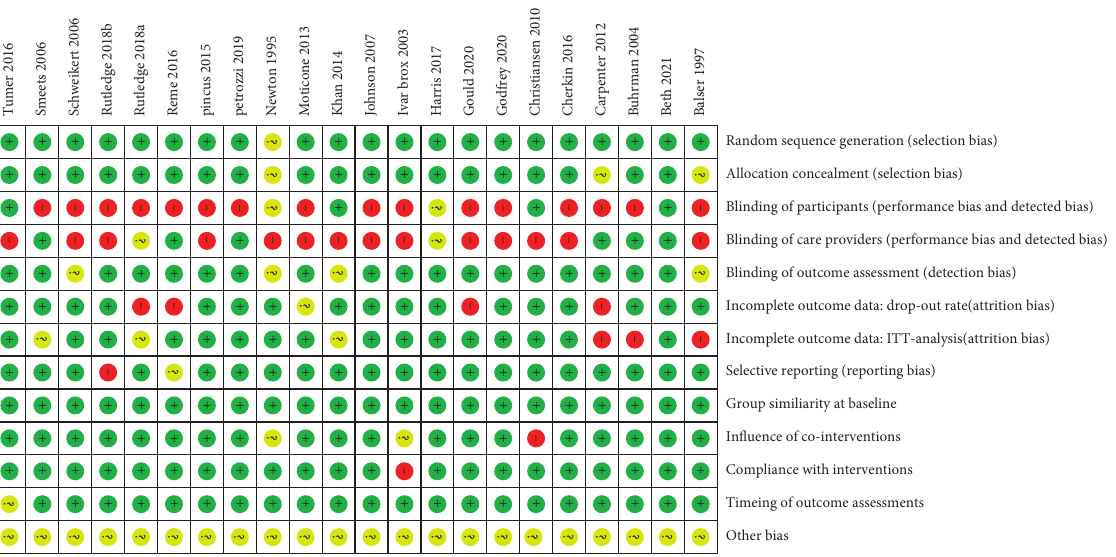
Figure 2: Risk of bias of the included studies. Most studies were low risk in the selection bias, while the performance and detected bias were high